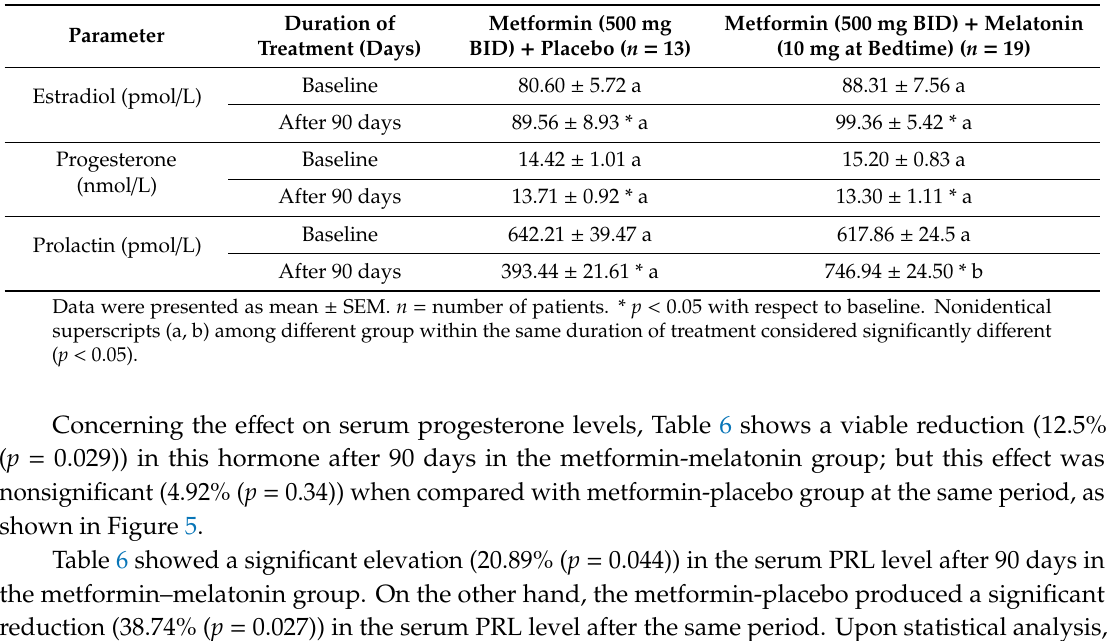
Table 6. E ff ect of treatment with a combination of metformin-melatonin versus metformin-placebo on some hormones in MEBS